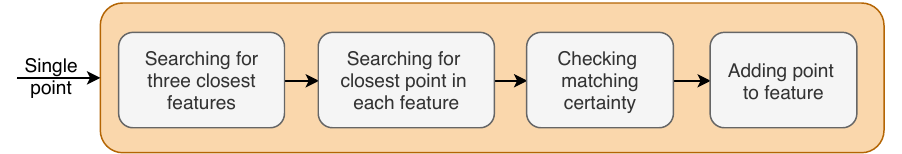
Figure 5. Steps performed to match a single point to an existing